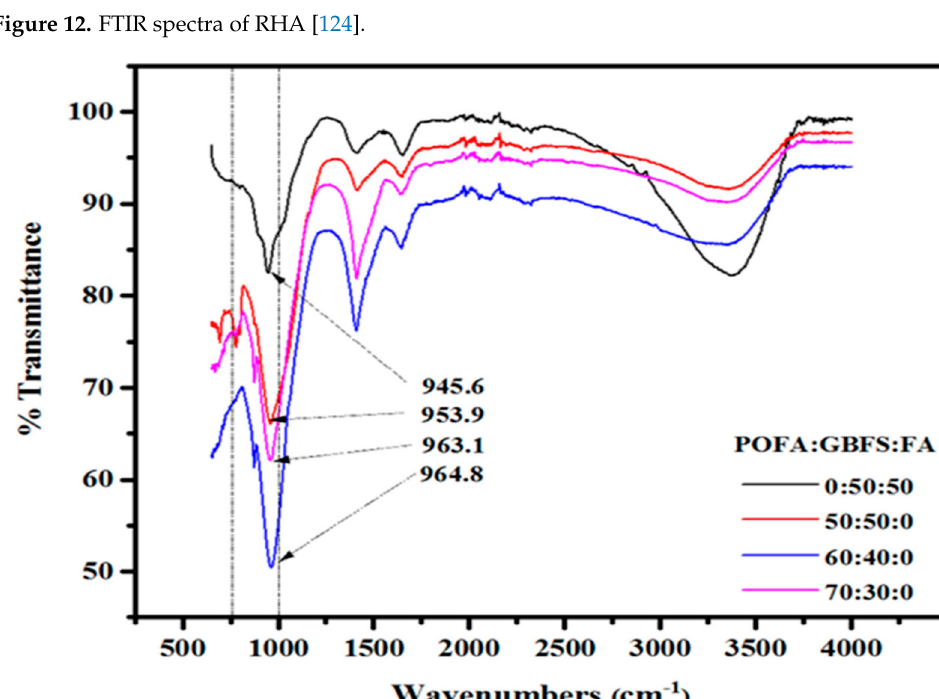
Figure 13. FTIR of AAMs with different POFA levels [126].